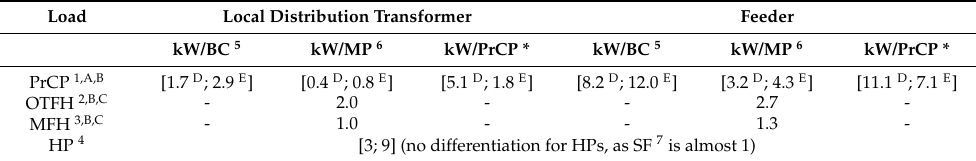
Figure 28. Maximum simultaneous conventional power consumption per household metering point based on [41]. Table 10. Power value assumptions for different loads in the low-voltage